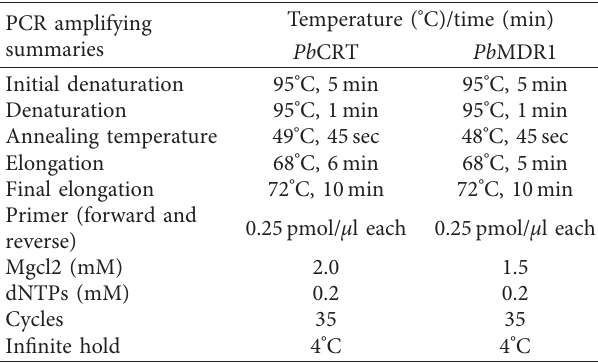
Table 1: Summary of PCR programme.